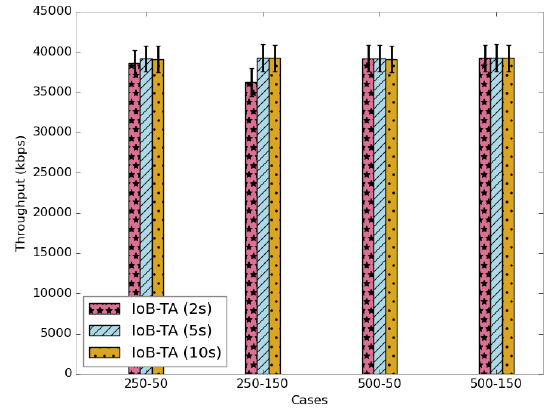
Figure 30. Average throughput for IoB-TA.